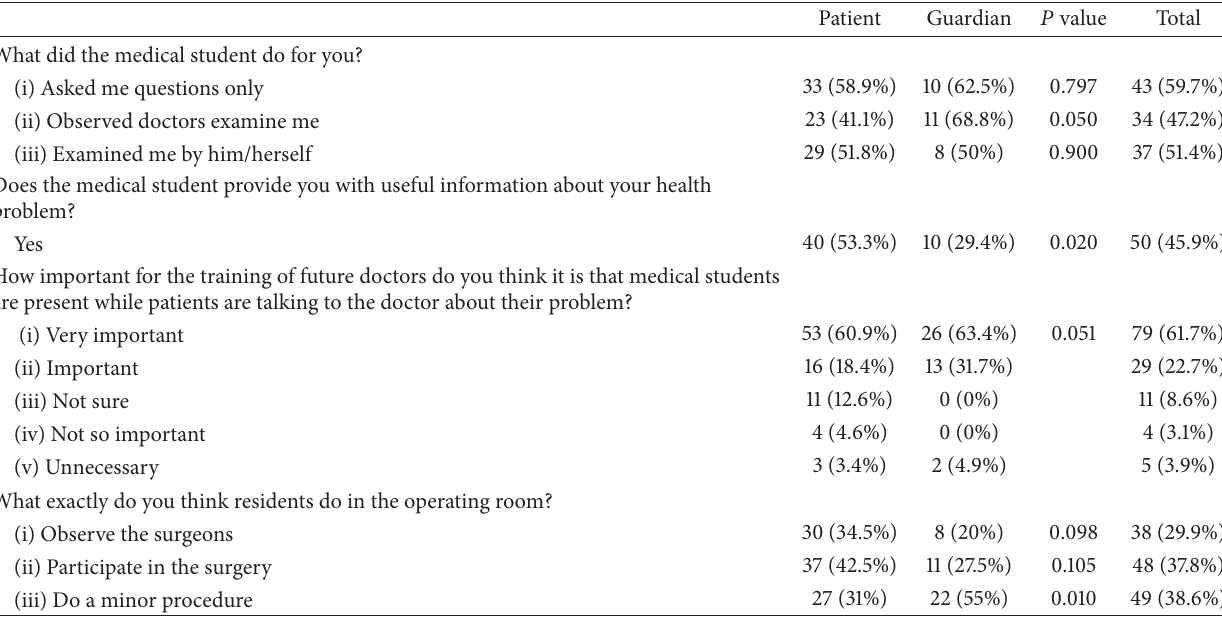
Table 4: Guardians views and their experience with medical students.